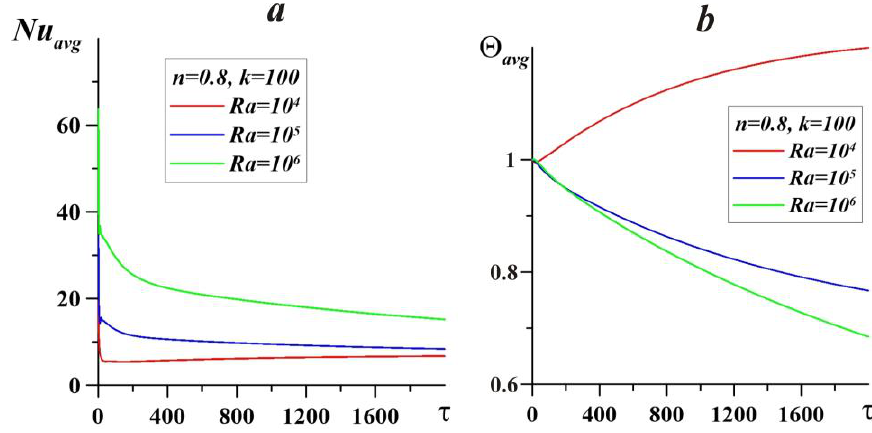
Figure 6. The time dependences of the average Nusselt number ( a ) and average temperature ( b ) at n = 0.8, k = 100, Pr = 10 2 and different Rayleigh numbers.